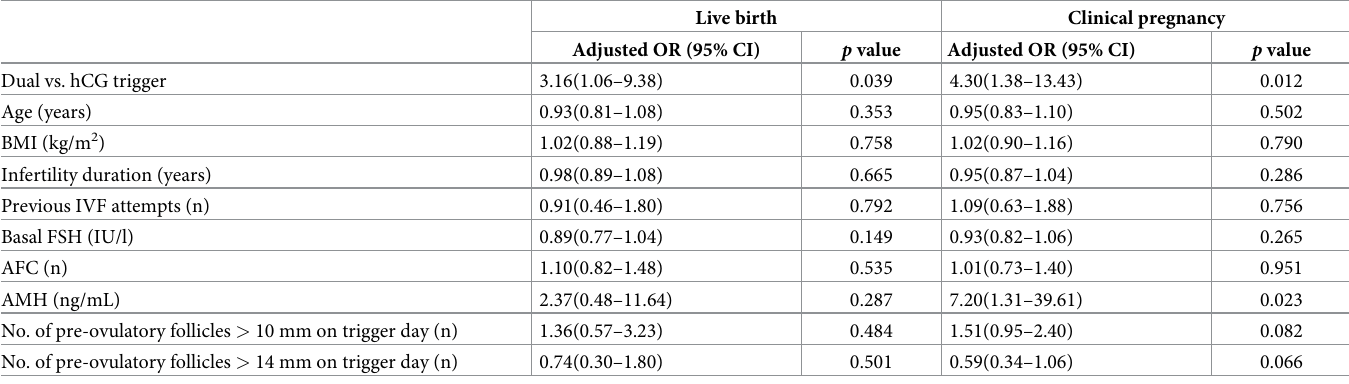
Table 4. Analyses of factors affecting live birth and clinical pregnancy in older patients with diminished ovarian reserve (POSEIDON group 4) using generalized estimating